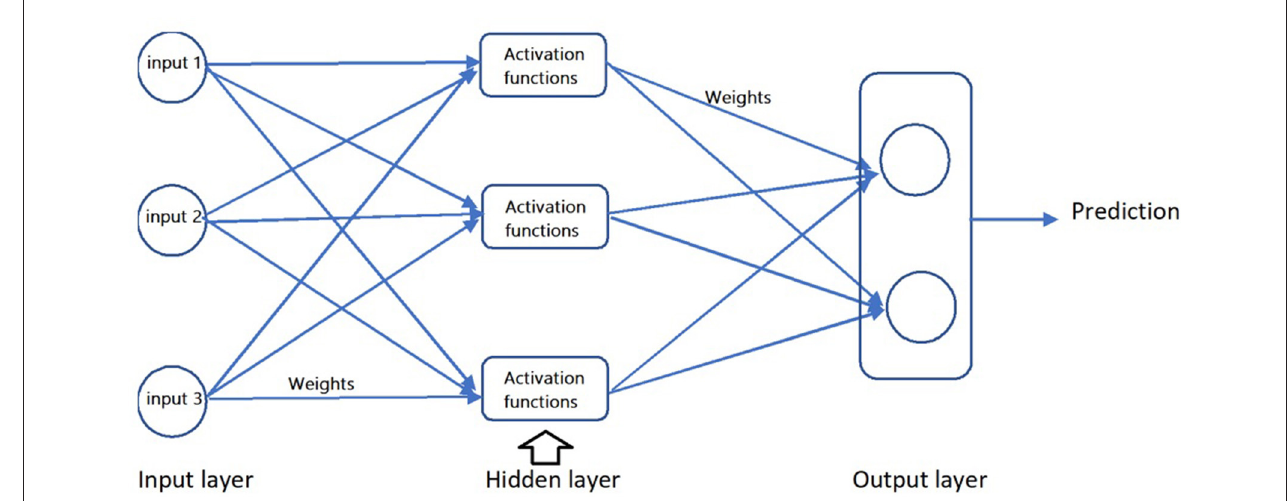
FIGURE 1 | Structure of ANN with one hidden